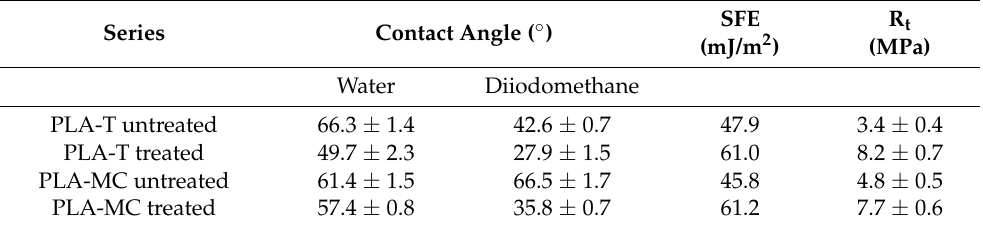
Table 2. Wetting, SFE, and tensile shear strength (R t ) of PLA-T and PLA-MC